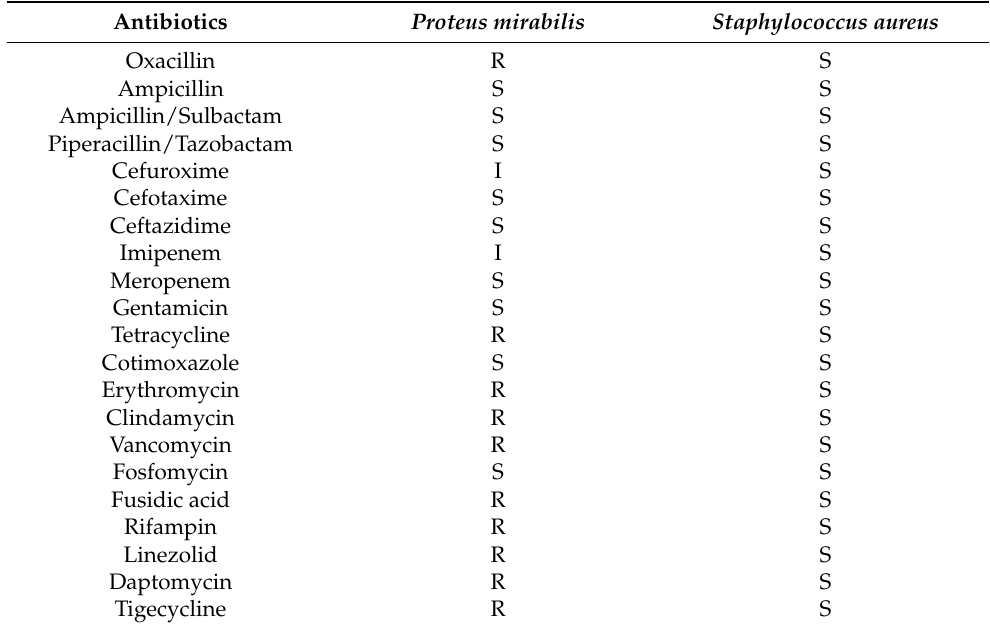
Table 1. Susceptibility profile of Proteus mirabilis and Staphylococcus aureus (S: sensitive, I: intermediate resistant, R: